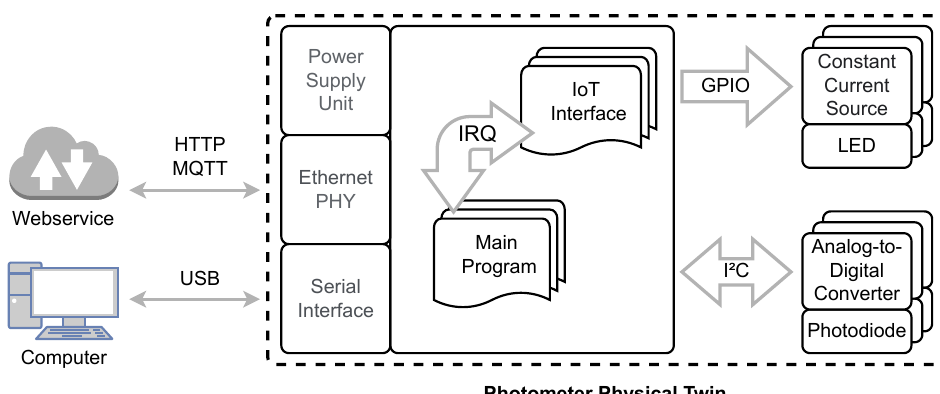
Figure 3. Schematic Layout of the Physical Photometer